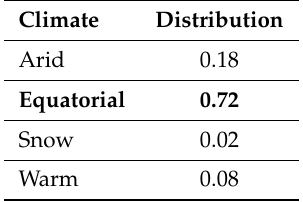
Table 9. Overall distribution of the categorical variable